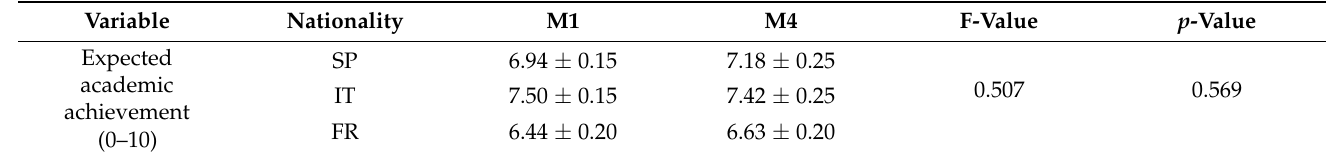
Table 4. Expected academic achievement in the oral final thesis defense